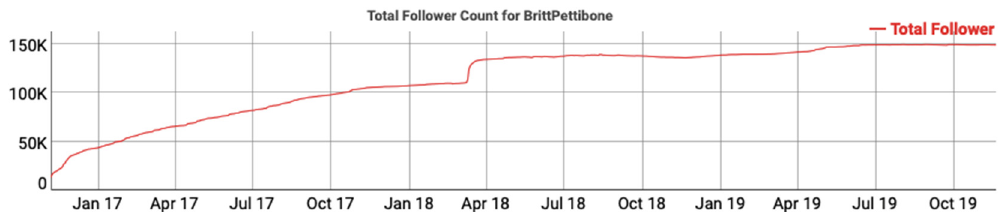
Figure 5. Total Twitter followers Brittany Pettibone—Social Blade.